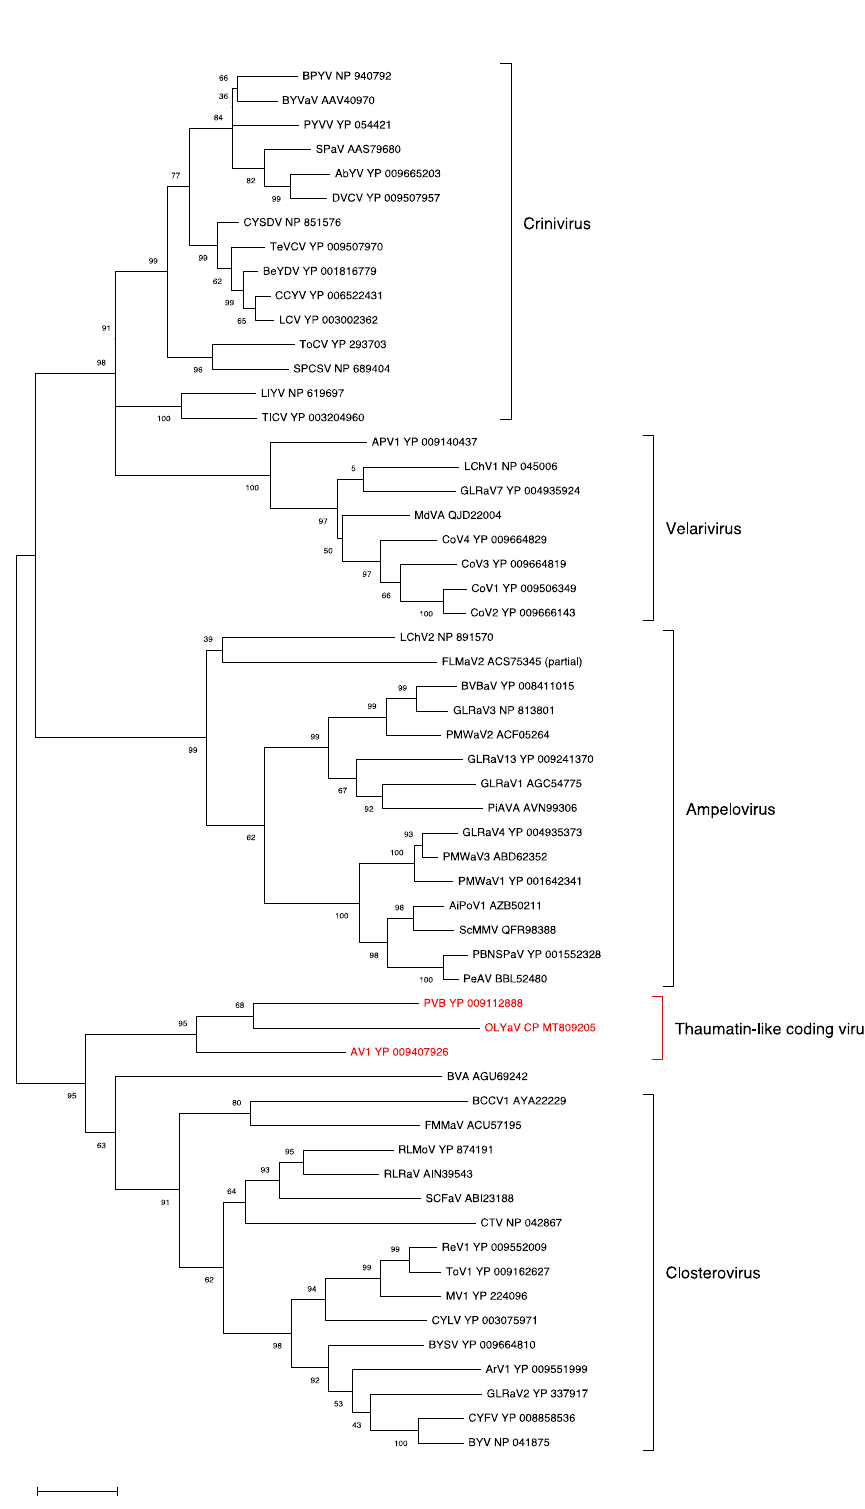
Figure 10. Maximum likelihood phylogenetic tree using the best substitution model by MEGA X of CP from representative members of the family Closteroviridae . Proteins of the isolates are identified by their protein_id number. The scale bar shows the genetic distance. Bootstrap percentages (500 re-samples) are indicated on the branches.